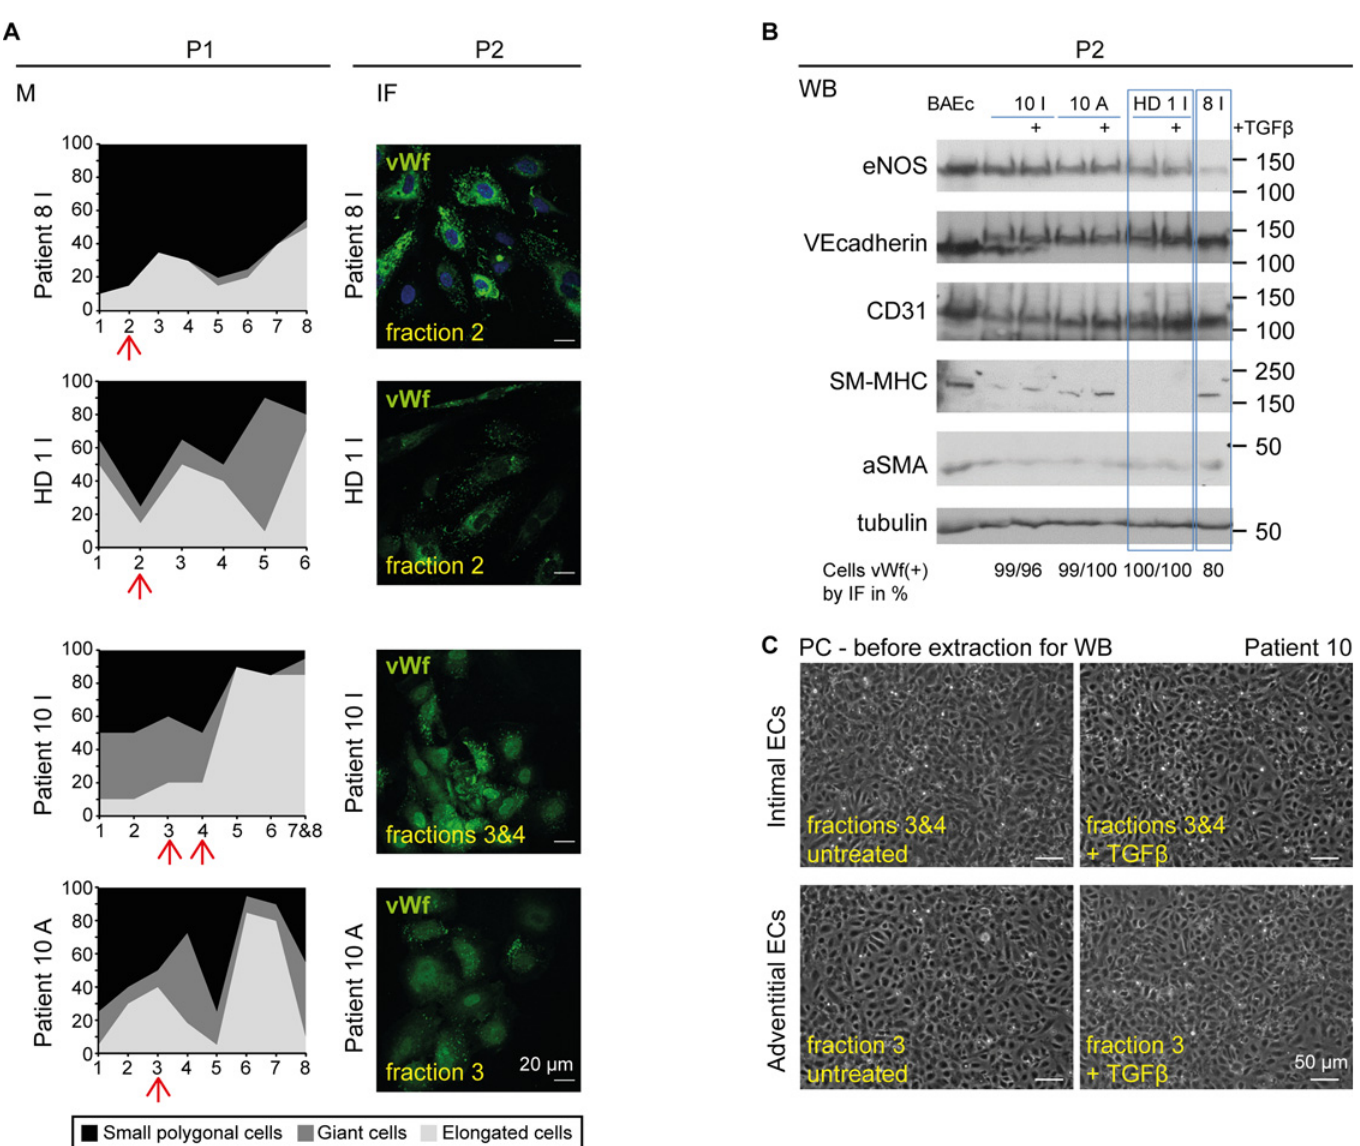
Fig 4. Analysis of proliferating cells: selection of EC-enriched fractions and validation of procedure. ( A ) The left-hand morphologic diagram (M) shows the fraction used (arrow) for western blot analysis in (B) (WB). The high percentage of ECs was confirmed in the corresponding vWf immunofluorescent staining (IF), performed at P2 (200 cells were scored). ( B ) P2 ECs isolated with the recommended procedure from three patients: 8I, 1I (HD) and 10I and A, were lysed and analyzed for three EC and two mesenchymal markers by SDS PAGE. ( C ) Representative phase contrast (PC) images of the cells from the fractions selected for patient 10, stimulated or not by TGFbeta, before cell lysis and western blot analysis, are shown. The biochemical studies performed at P2 cross- validate the morphologic (performed at P0 and P1 stage by phase contrast imaging) and immunophenotypic (performed at P0 and P2 stage by immunofluorescent staining) characterization of the isolated